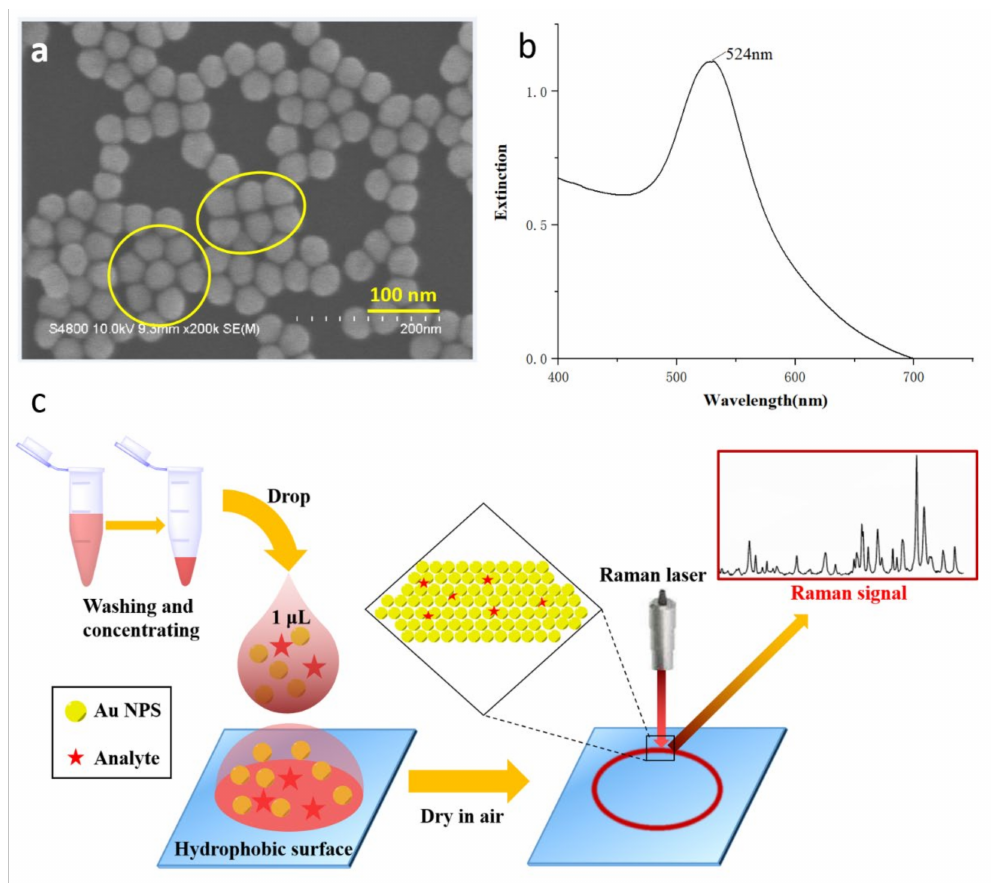
Figure 1. ( a ) SEM and ( b ) UV − vis spectrum of the as-prepared Au NPs. ( c ) Schematic process cartoon of the optimization of coffee ring effect and analyte